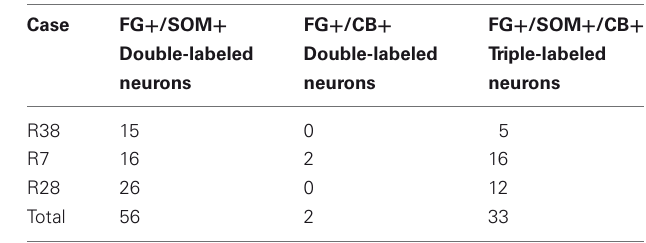
Table 1 | Cell counts of double and triple-labeled neurons in the amygdala in sections labeled for FG, SOM, and NPY.